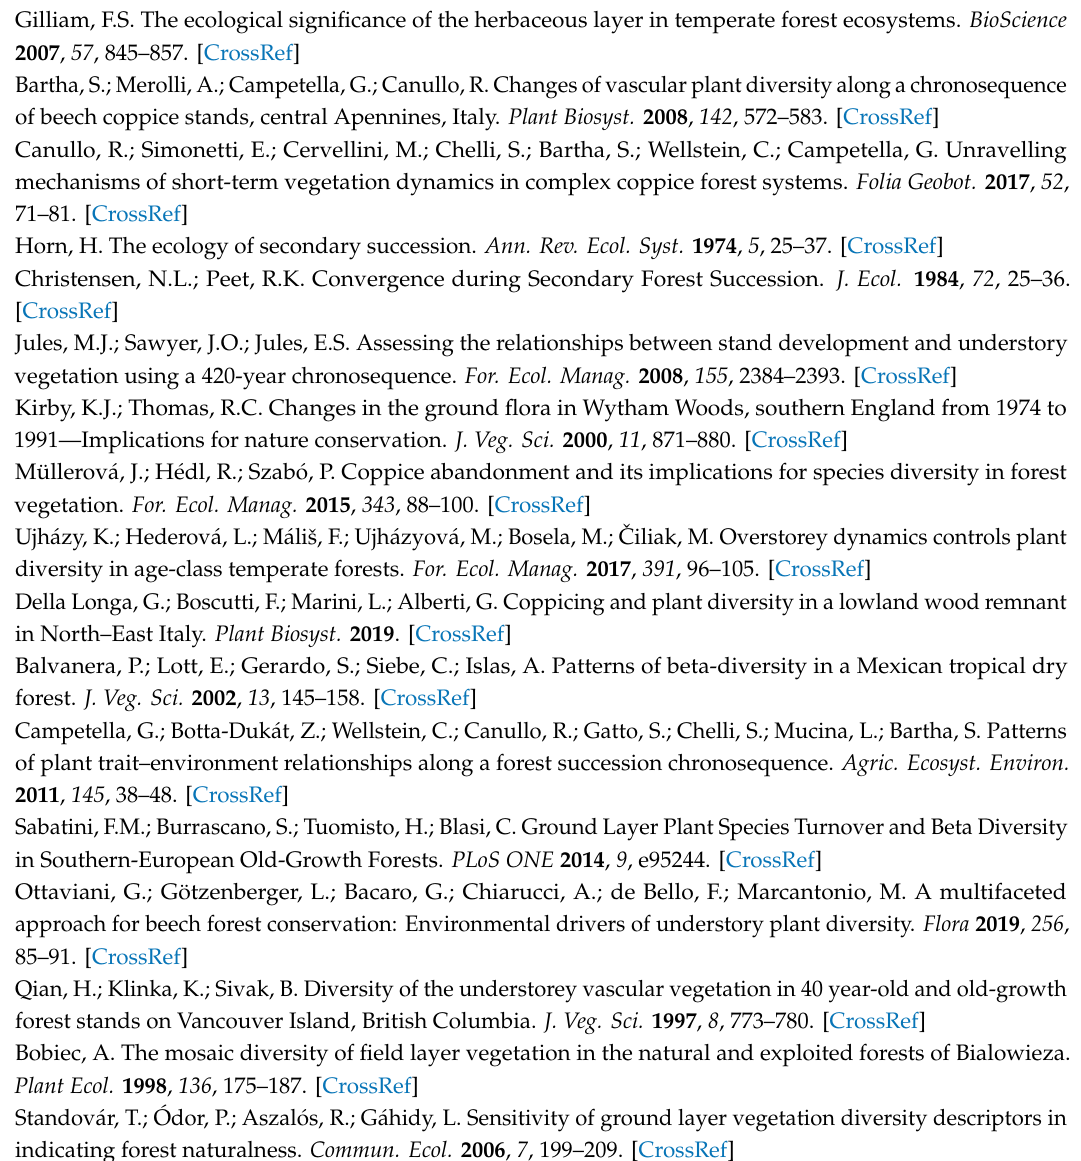
Table S1: Mean Ellenberg indicator values for each site; Table S2: parameters of the three best performing regression models; Figure S1: location of the study area and sampling scheme; Figure S2ab Demonstration of details of sampling and analyses of NRC and CD using binary data; Figure S2c Illustration of sampling processes for abundances from base-line transects. Figure S3: Beta diversity trends along the chronosequence (represented by Bray–Curtis Dissimilarity); Figure S4: Example of spatial patterns detected in the